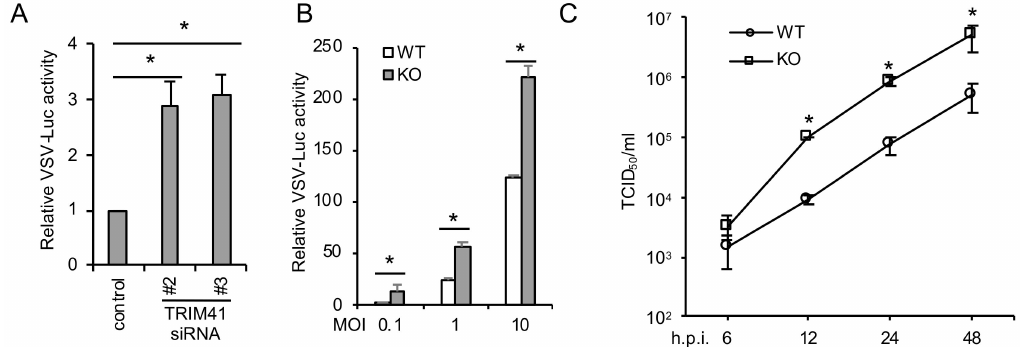
Figure 2. Depletion of TRIM41 increases host susceptibility to VSV infection. ( A ) A549 cells were transfected with 5 pmol of the control siRNA or the indicated siRNA duplex against TRIM41. After 48 h, the cells were infected at an MOI of 0.1 with VSV-Luc for 12 h. Relative VSV activities were determined repeated three times. Data represent means ± standard deviations of three independent